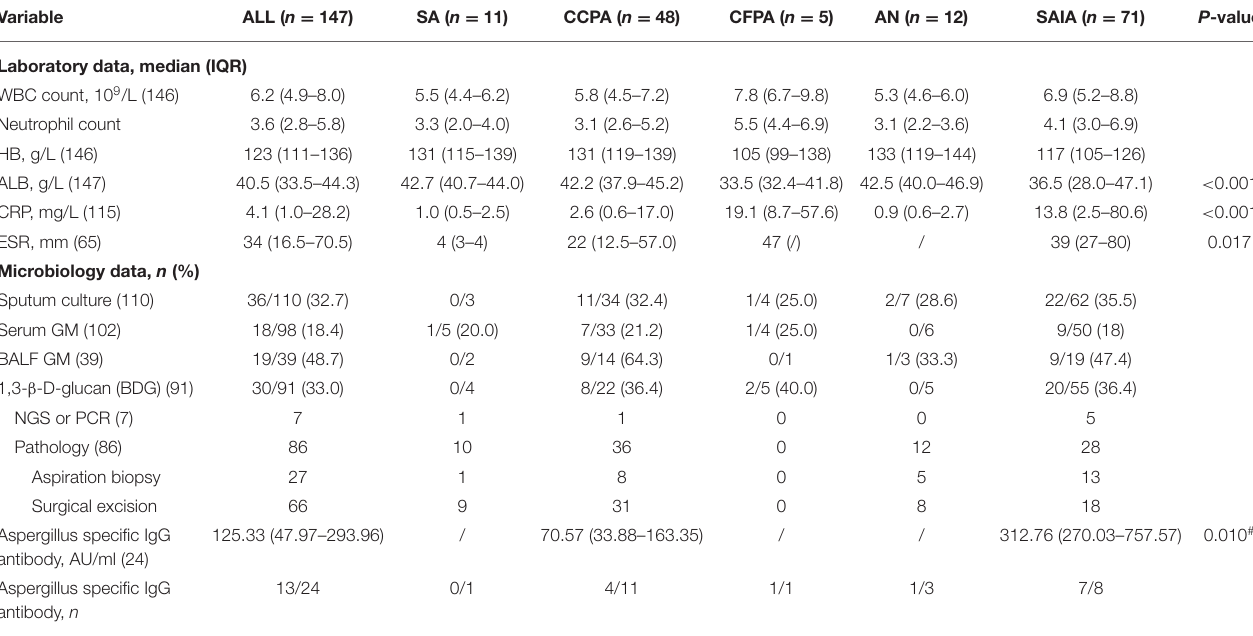
TABLE 3 | Laboratory and microbiology data of patients with CPA in different subtypes.